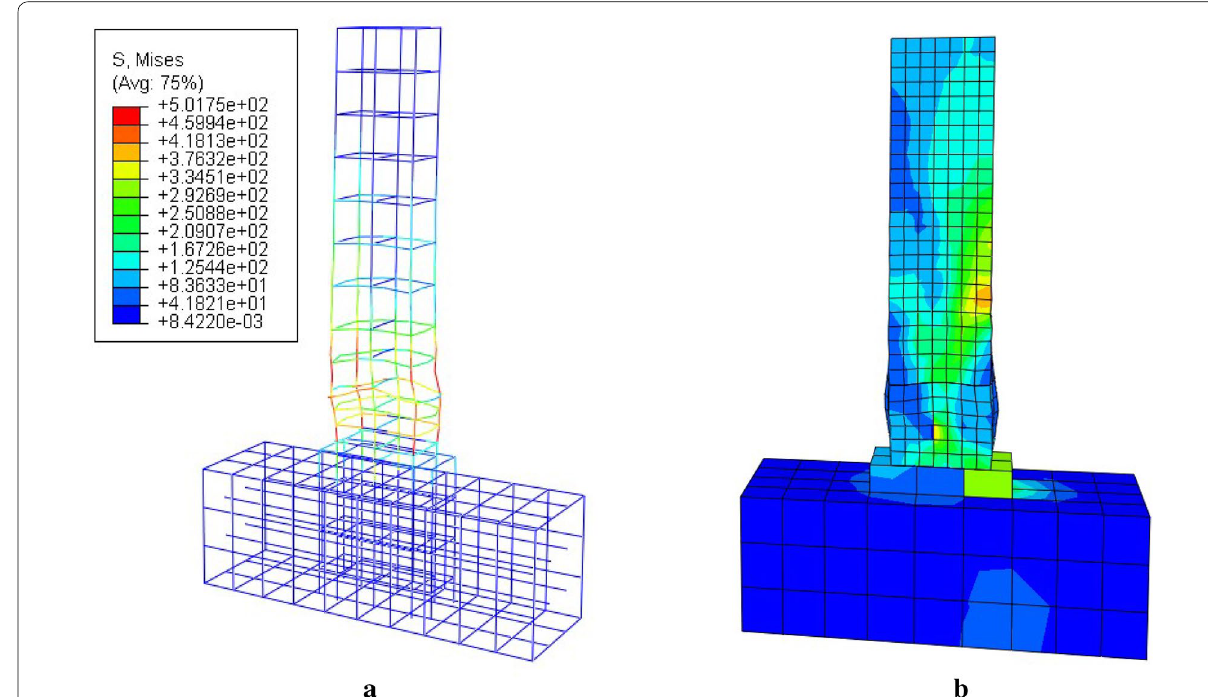
Fig. 13 Failure modes of specimen ZP6 (failure state): a stress conditions at the reinforcements; b stress condition at